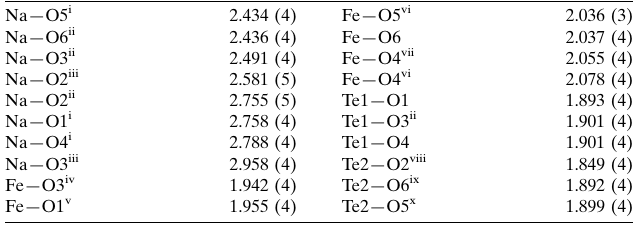
Selected bond lengths (A˚